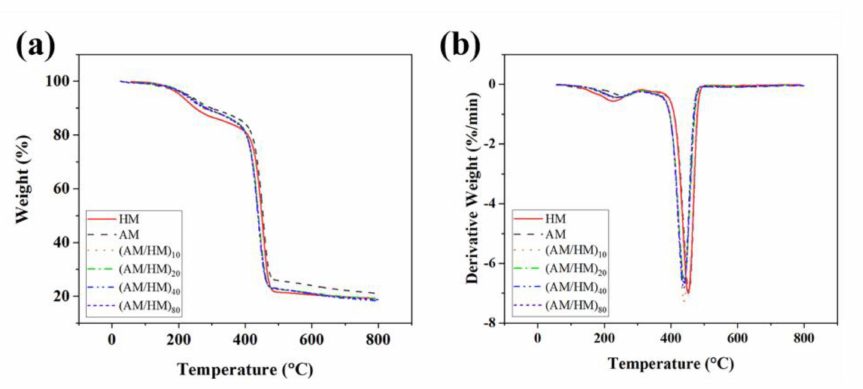
Figure 8. TGA ( a ) and DTG ( b ) plots of the multilayer EPDM composites under nitrogen atmosphere.